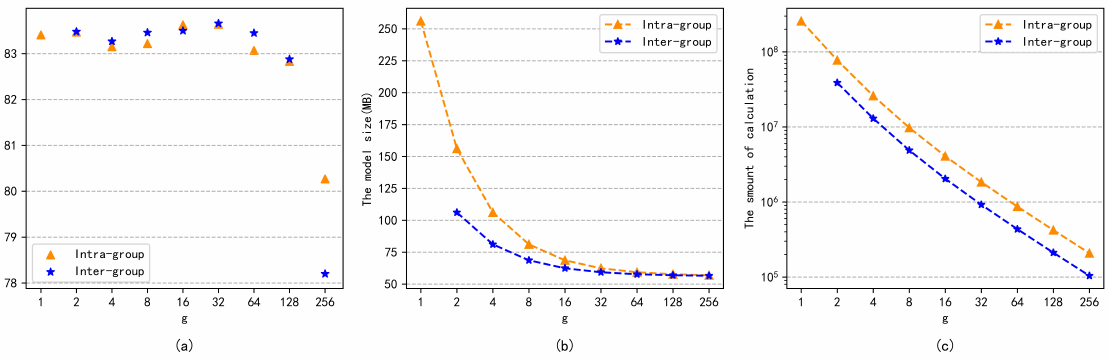
Figure 3. ( a ) The classification accuracy of Intra-GBP and Inter-GBP based on VGG-16 on CUB dataset; ( b ) The corresponding model size with different g (including backbone CNN); ( c ) The amount of calculation for pooling and classification.